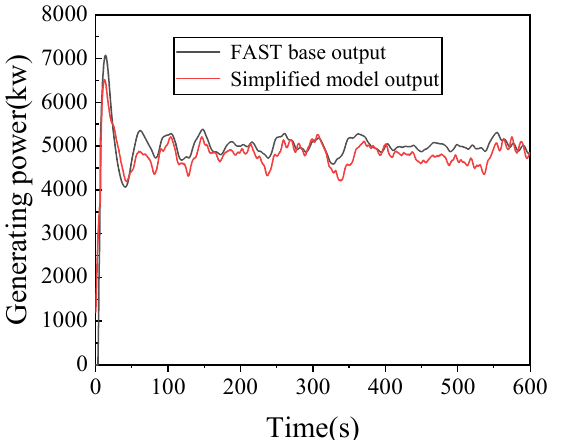
Figure 2. Comparison of henerator power between the base output of FAST and the output of the simplified model.